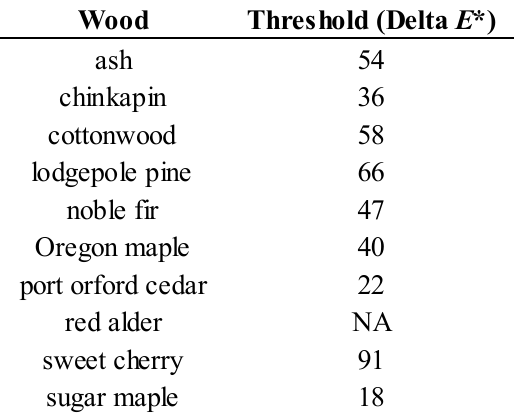
Table 2. Minimum delta E * values required for a visual color change, by wood species.